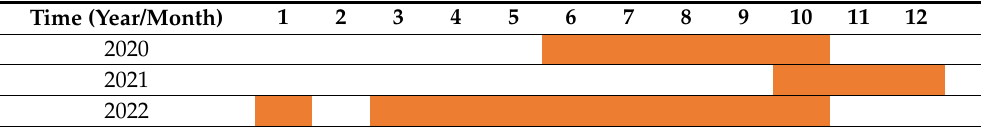
Table 3. Time information for UAV stereo image data acquisition. Orange represents the image acquisition time.